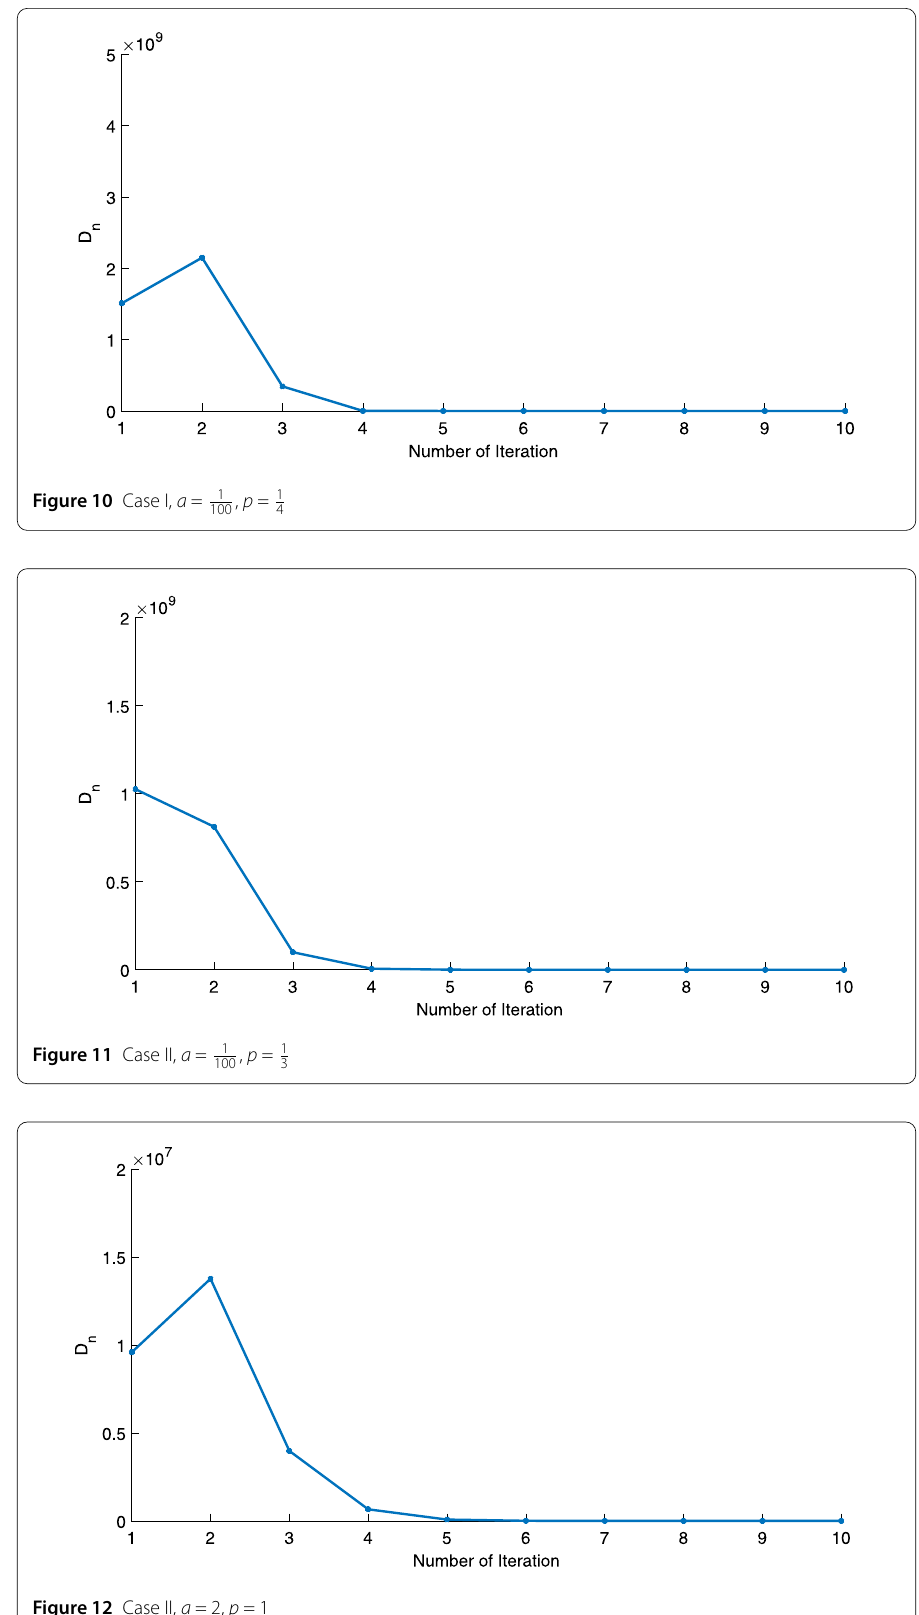
Figure 12 Case II, a = 2, p =